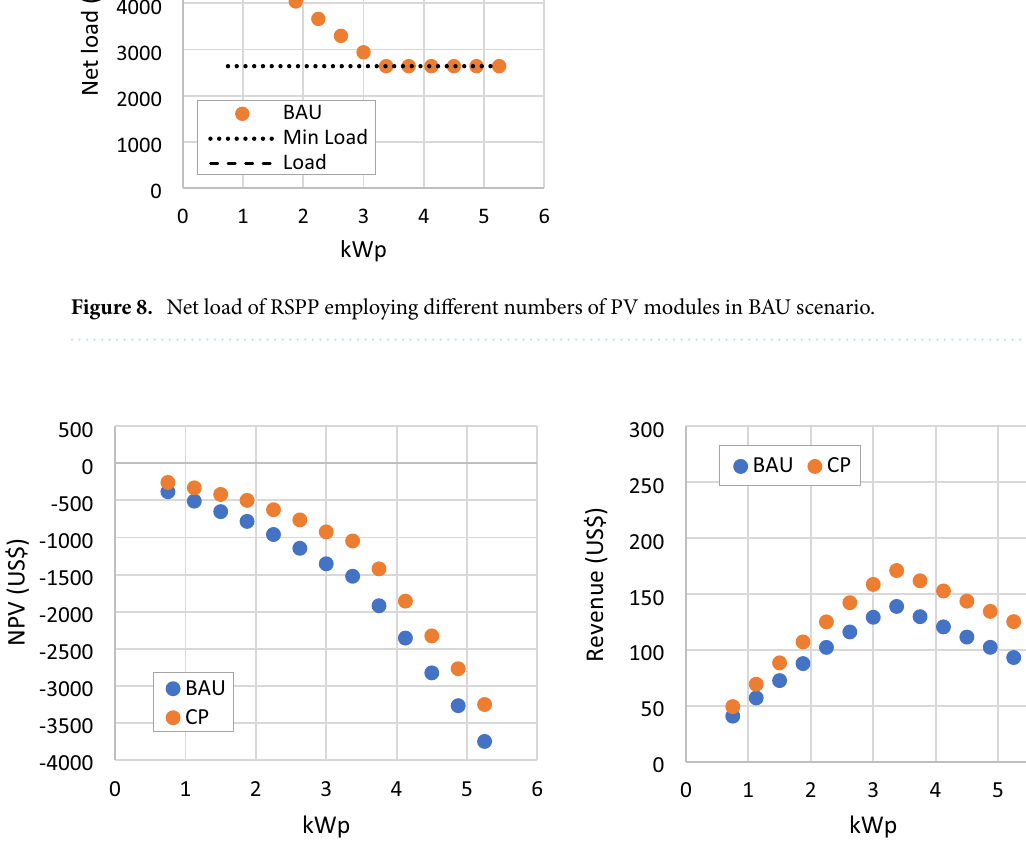
Figure 9. NPV and annual revenue of RSPP with different number of PV modules in BAU and CP